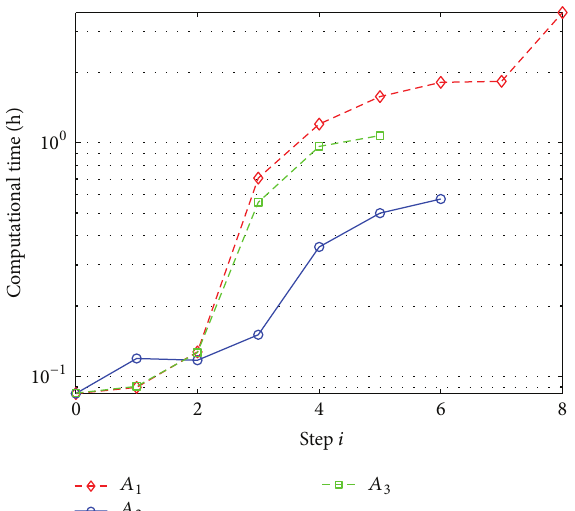
Figure 4: Evolution of the computational time for each step with strategies 𝐴 1 , 𝐴 2 , and 𝐴 3 . The cumulate computational time is about 11 hours for 𝐴 1 , 2 hours for 𝐴 2 , and 3 hours for 𝐴 3 .